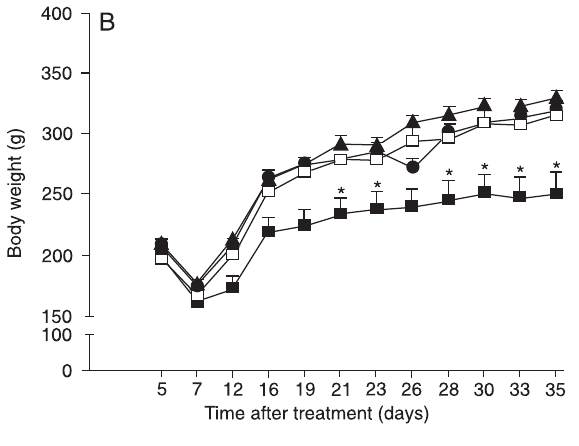
Figure 1. Blood glucose, body weight and glucose tolerance